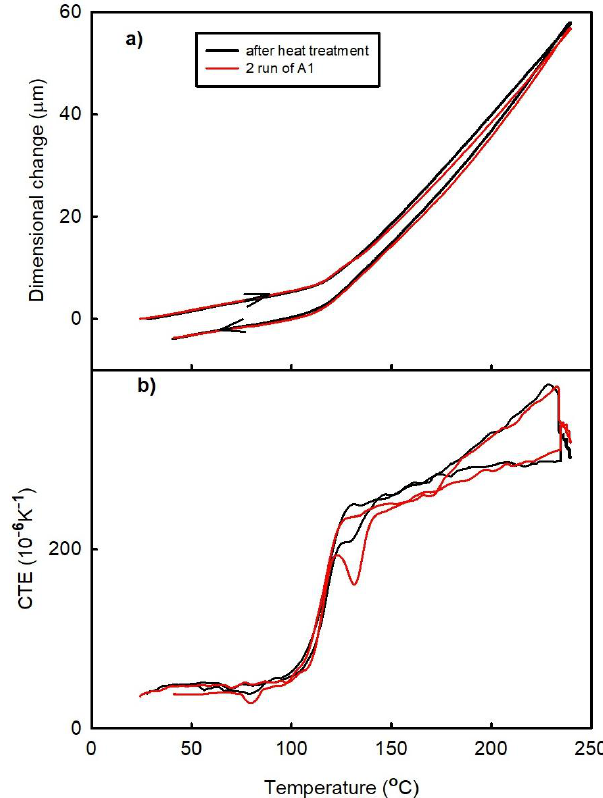
Figure 8. Temperature dependences of the ( a ) dimensional changes and ( b ) CTE of the A1 sample (FR4 laminate) observed after the heat treatment at 145 °C.